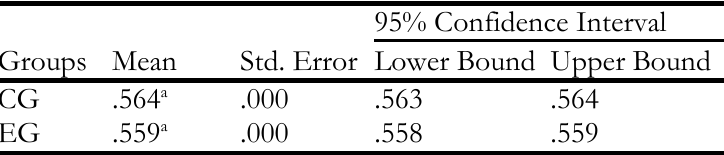
Table 3. Estimated Marginal Means of Fluency Scores in the Two